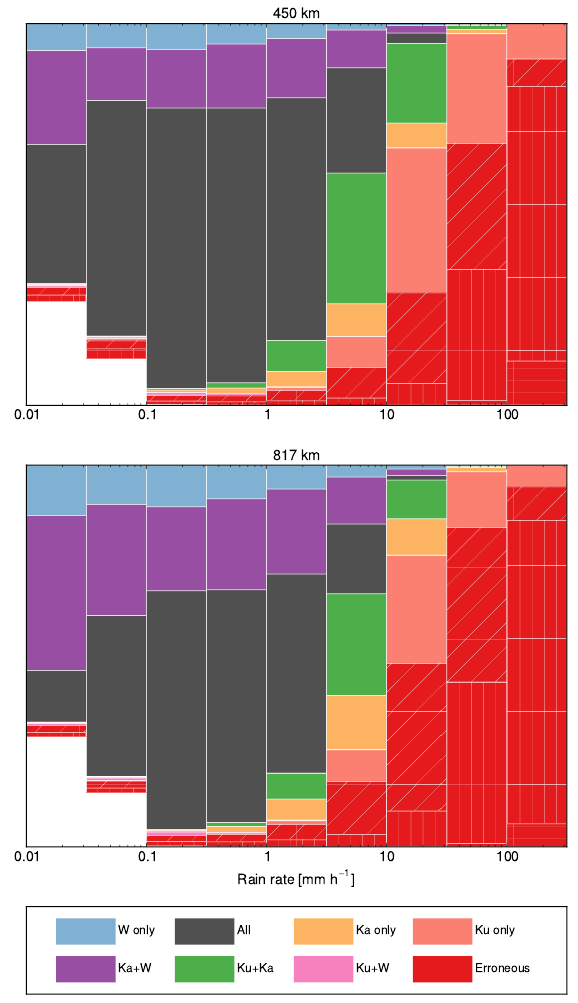
Figure 5. Global statistics of detection segmented by surface pre- cipitation rate. The data used are the reflectivities at 400m altitude. The white regions correspond to points that are below the mini- mum detectable signal at all bands, while the red bars indicate the type of error by their stripe pattern: diagonal stripes for NUBF (er- ror category 1), vertical stripes for severe NUBF (category 2), and horizontal stripes for multiple scattering (category 3). Point that are attenuated (category 4) at all bands are rare at all rain rates, and as such, not visible in the